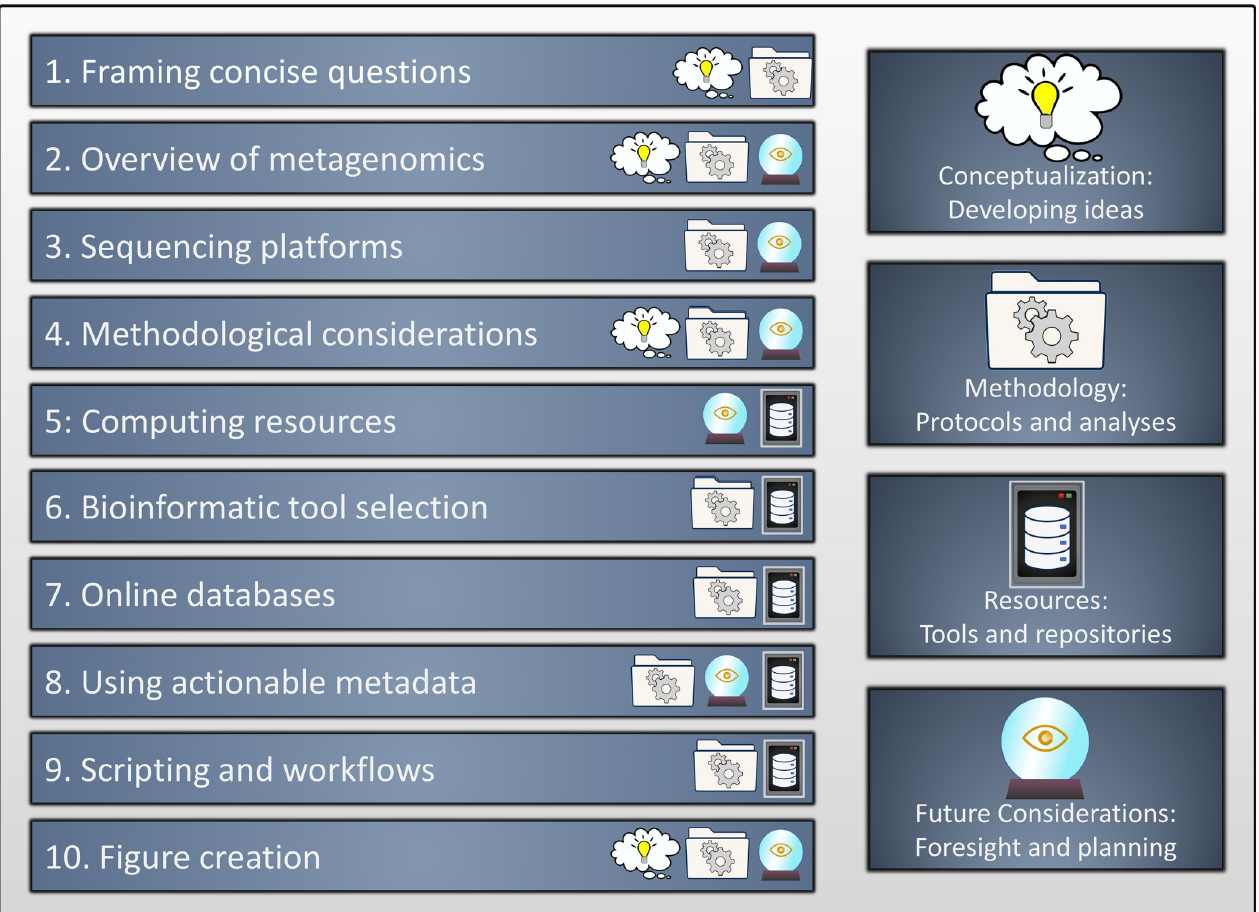
Fig 1. The 10 points outlining the metagenomic approach of microbial ecology. The summary of what is presented, along with the vital aspects discussed within each